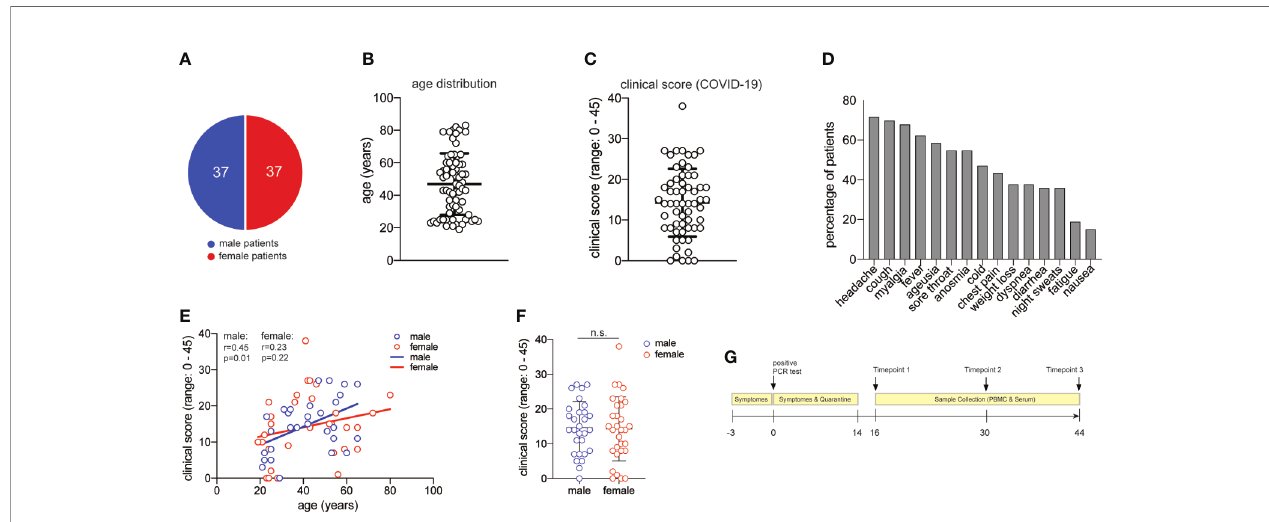
FIGURE 1 | Characterization of the COVID-19 patient cohort. (A) distribution of male and female study participants. (B) distribution of the age of all study participants (mean ± SEM, 47.3 ± 2.2). (C) clinical score for each patient (range:0-38) as assessed by a physician assisted questionnaire with each symptom score (range: 0-3) contributing to the fi nal score (mean ± SEM, 14.5 ± 1.1). 60 patients provided clinical metadata. (D) frequency of patients presenting with the symptoms assessed in the COVID-19 questionnaire. (E) Spearman correlation r between age and clinical score for male and female patients, respectively. (F) clinical scores as in (C) for male and female patients (unpaired student ’ s t test, n.s., not signi fi cant) (mean ± SEM; male: 14.7 ± 1.4; female: mean 14.3 ± 1.7). (G) Timeline of acquisition of patient